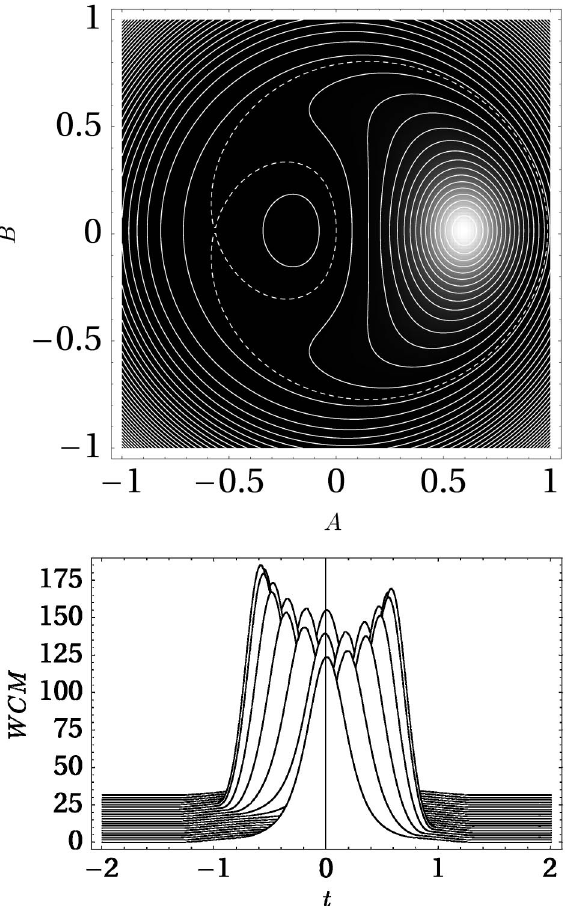
FIG. 14. (a) Phase space density (gray scale) and contours of background.FIG. 13. (a) Phase space density (gray scale) and contours of constant energy K (cid:3) A; B (cid:4) (particle trajectories). (b) Simulated constant energy K (cid:3) A; B (cid:4) (particle trajectories). (b) Simulated wall current monitor data. The solution was obtained with * (cid:1) wall current monitor data. The solution was obtained with * (cid:1) (cid:1) 0 : 1 , C (cid:1) 0 : 005 , ‘ (cid:1) 0 : 01 , C (cid:1) 92 191 , 1 : 2 , ~ rr (cid:1) 0 : 025 , C 1 3 0 (cid:1) 0 : 1 , C (cid:1) 0 : 005 , ‘ (cid:1) 0 : 01 , C (cid:1) 21975 , 0 : 3 , ~ rr (cid:1) 0 : 025 , C and (cid:24) (cid:1) 0 : 0022 . This solution has comparable density in the 1 3 0 and (cid:24) (cid:1) 0 : 014 . This solution consists of a large soliton with soliton and the little background, i.e., almost all particles are trapped in the